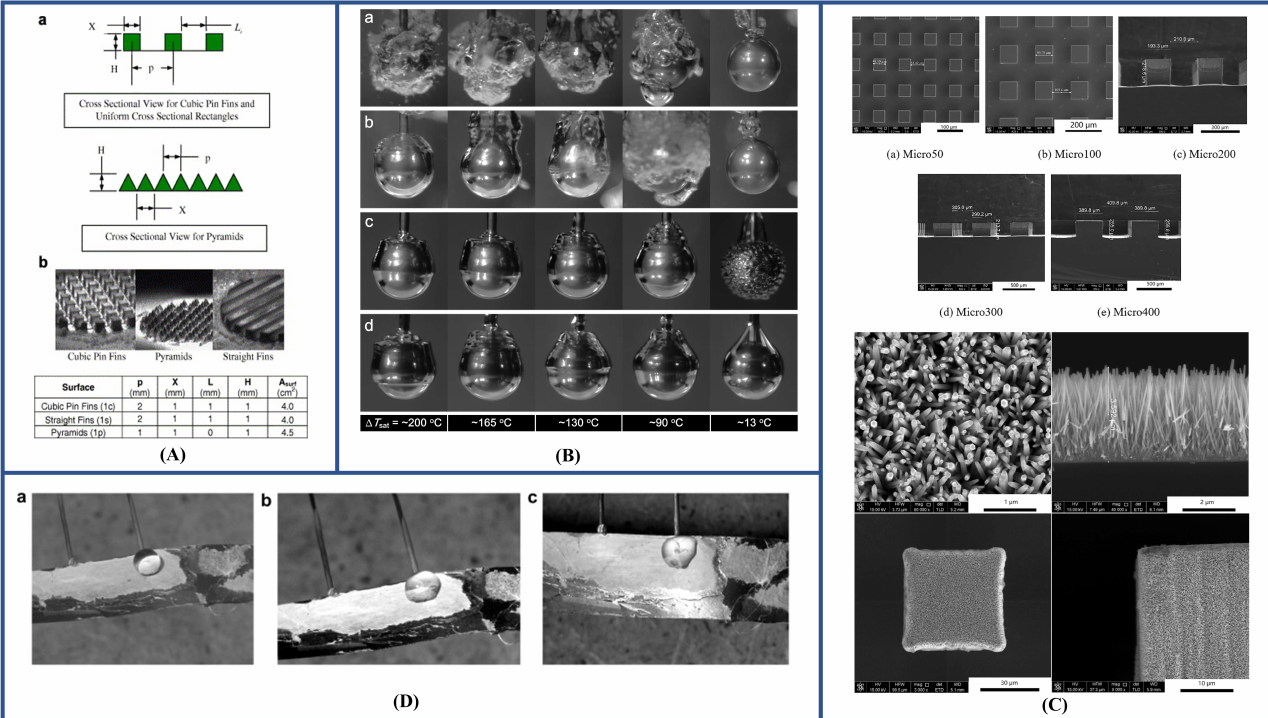
Figure 7. The characteristics of enhanced heat transfer surfaces. ( A ): Different reinforced surfaces (square ribs, pyramid ribs and straight ribs) [80]. ( B ): Snapshots of dynamic vapor film and bubble evolution process during quenching in the instance of several typical wall superheats on the ( a ) nanostructured superhydrophilic, ( b ) clean hydrophilic, ( c ) coated hydrophobic and ( d ) nanostruc- tured superhydrophobic surfaces [118]. ( C ): SEM images of micro-structured surfaces and hybrid micro-nanoengineered surfaces applied in the spray cooling system [125]. ( D ): Pictures of drops deposited on an unheated strip coated with a PAN nano-mat ( a ) immediately after deposition; ( b ) 10 min after deposition; ( c ) 17 min after deposition [112]. 3.2. Numerical Simulation Computational fluid dynamics (CFD) is a significant method for predicting the evap- orative cooling potential and the process of a jet system. Due to the complexity of the flow and heat exchange in the spray cooling process — involving heat surface bubble generation and detachment, convective heat transfer inside, evaporation process of thin liquid film and high-speed droplet impact such as the liquid membrane process — experimental methods are not rational approaches to measuring the inner liquid film flow and heat exchange process in detail. With improvements in computing capacity, CFD is considered to be a better alternative experimental method. In 2005, Selvam [126] proposed a multiphase flow calculation model using the level set model to capture the gas – liquid interface. The growth process of a single bubble in a liquid film with a thickness of 73.62 μm in the nuclea te boiling region was simulated. On